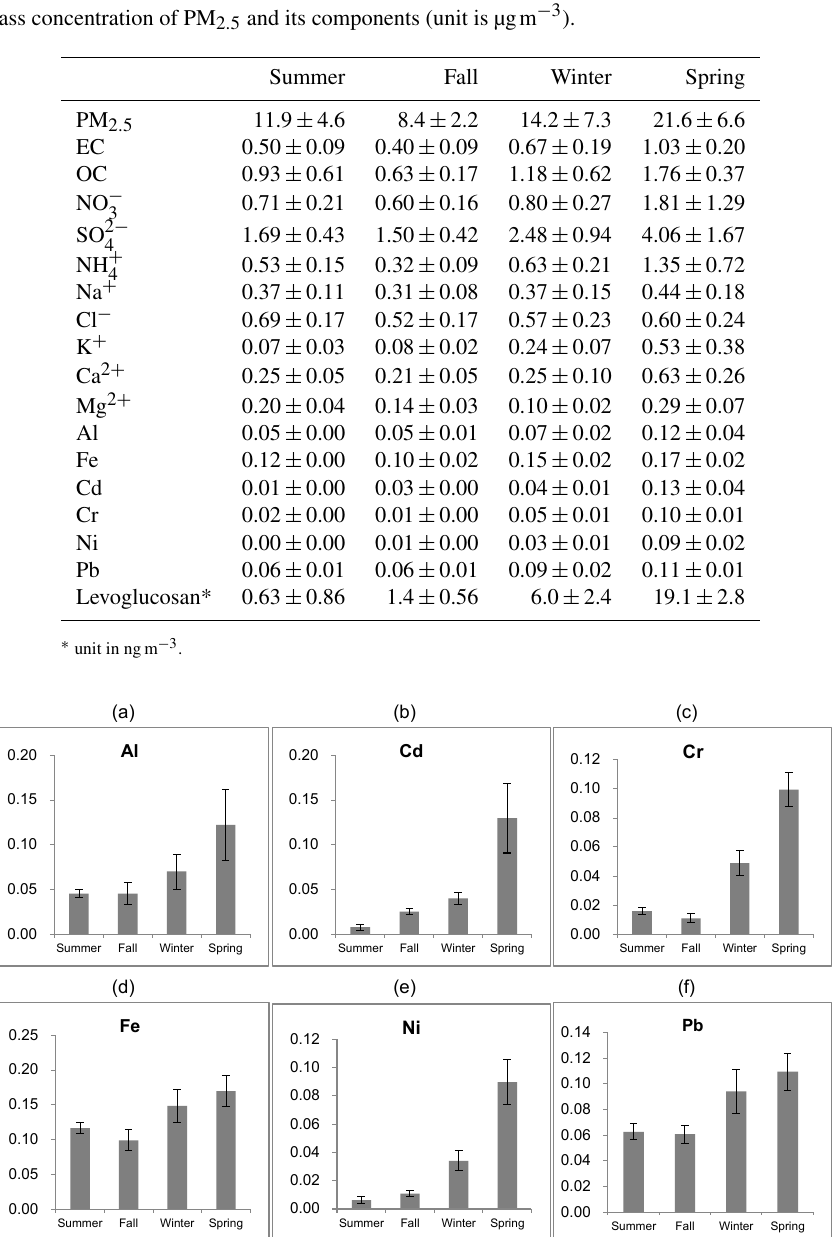
Figure 8. Seasonal mean mass concentration and standard deviation of metallic components (a) Al, (b) Cd, (c) Cr, (d) Fe, (e) Ni and (f) Pb (unit in µgm − 3